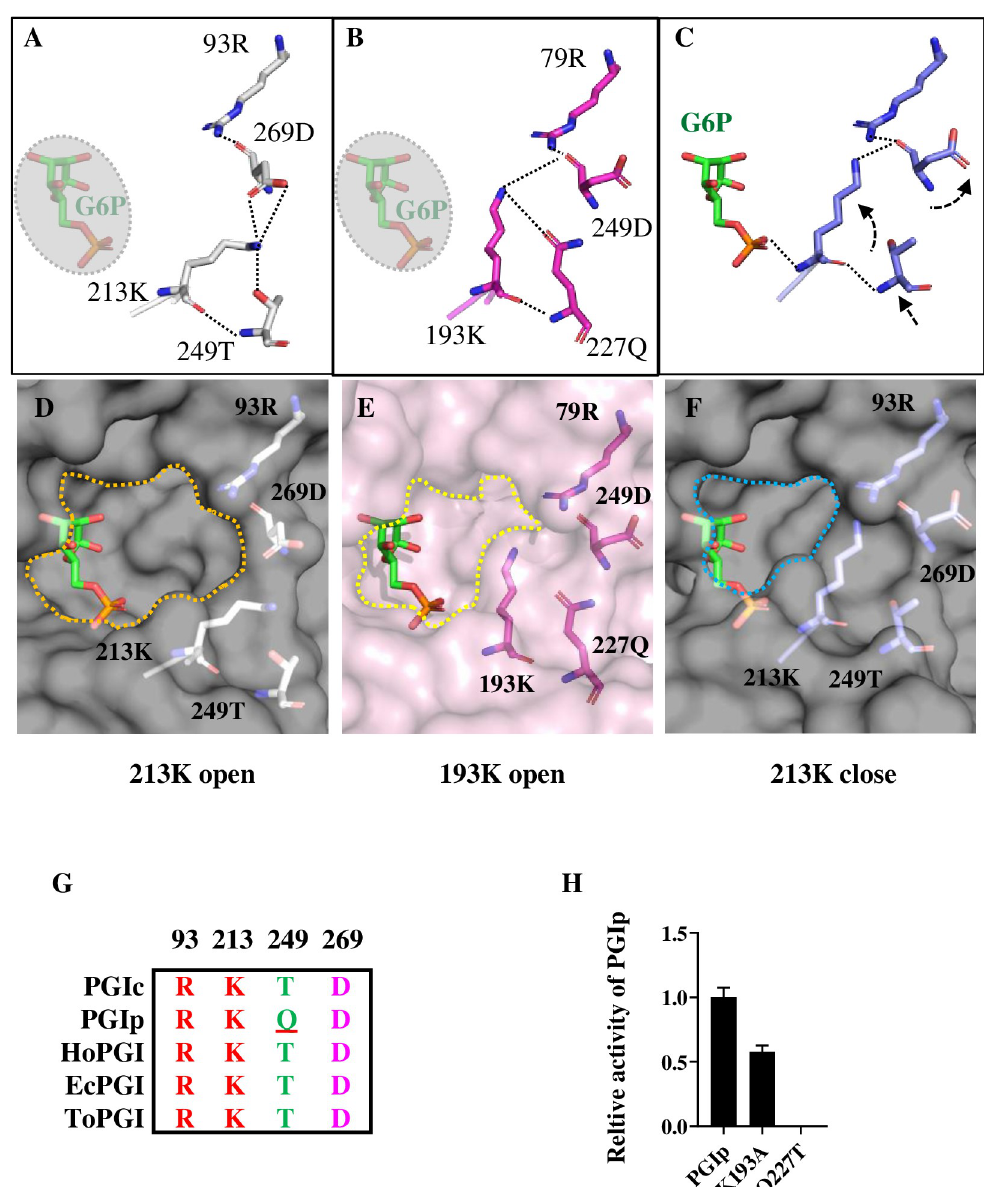
Fig 4. The residue Lys213 TaPGIc /Lys193 TaPGIp participates in substrate entrance and exit. A-C. Lys213 TaPGIc / Lys193 TaPGIp and its interacting residues surrounding the substrate binding pocket of TaPGIs. A shows Lys213 TaPGIc and its interacting residues (in white) in the open state of the binding pocket of TaPGIc. B shows Lys213 TaPGIc and its interacting residues (in blue) in the closed state of the binding pocket of TaPGIc. C shows Lys193 TaPGIp and its interacting residues (in magenta) in the open state of the binding pocket of TaPGIp, and G6P is in green. The black dotted arrows indicate the shift of some particular residues at the binding pocket gateway. D-F. Lys213 TaPGIc /Lys193 TaPGIp and its interacting residues superposed on the surface model of the substrate binding pocket of TaPGIs. Dotted lines show the substrate binding pocket gateway. G. The alignment of Lys213 TaPGIc /Lys193 TaPGIp and its interacting residues from different organisms. The residues of Arg93, Lys213, Thr249, and Asp269 in TaPGIc are conserved among HoPGIc (from Homo sapiens ), EcPGIc (from Escherichia coli ), ToPGIc (from Toxoplasma gondii ), and TaPGIp. H. The relative activities of TaPGIs and their mutation variants. The sites mutated in TaPGIs are indicated as subscripts. n � 3. Error bars indicate the standard